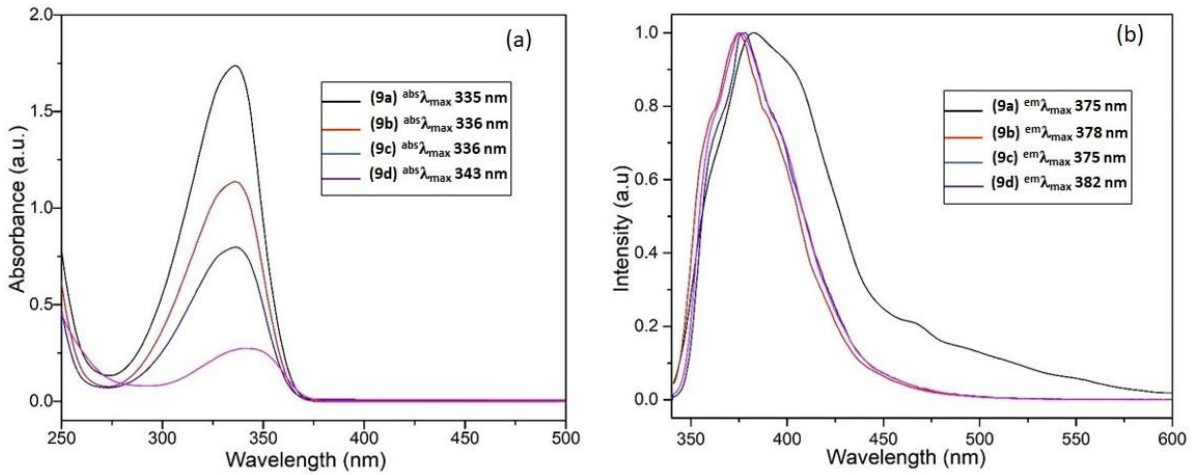
Figure 4. ( a ) UV – visible spectra of 9a – d in acetonitrile solution; ( b ) normalized fluorescence spectra of 9a – d at a concentration of 1 × 10 −6 M in acetonitrile solution.